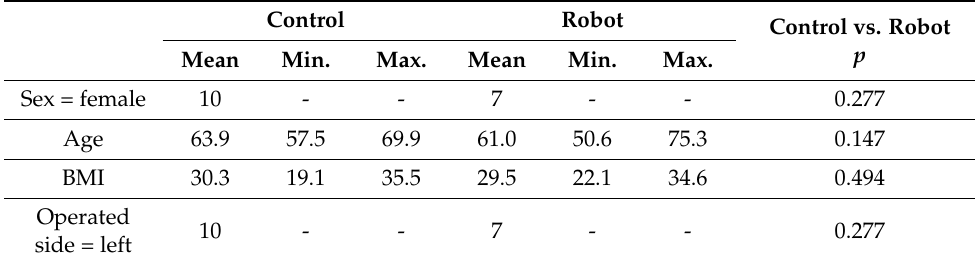
Table 1. Demonstrates basic patient parameters. p -values based on U -test. Control Robot Control vs. Robot